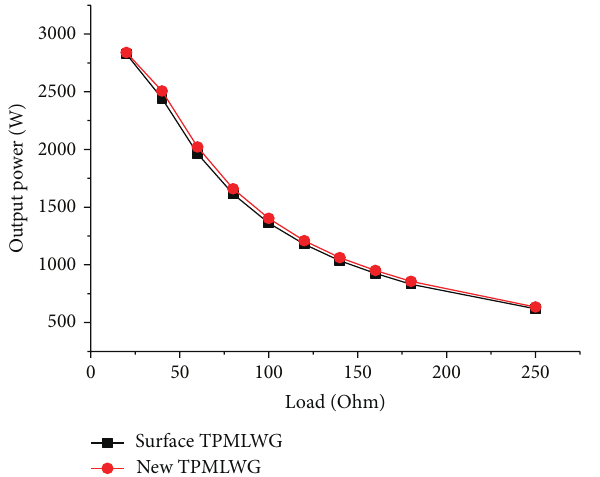
Figure 6: The output power of the TPMLWG in different load.